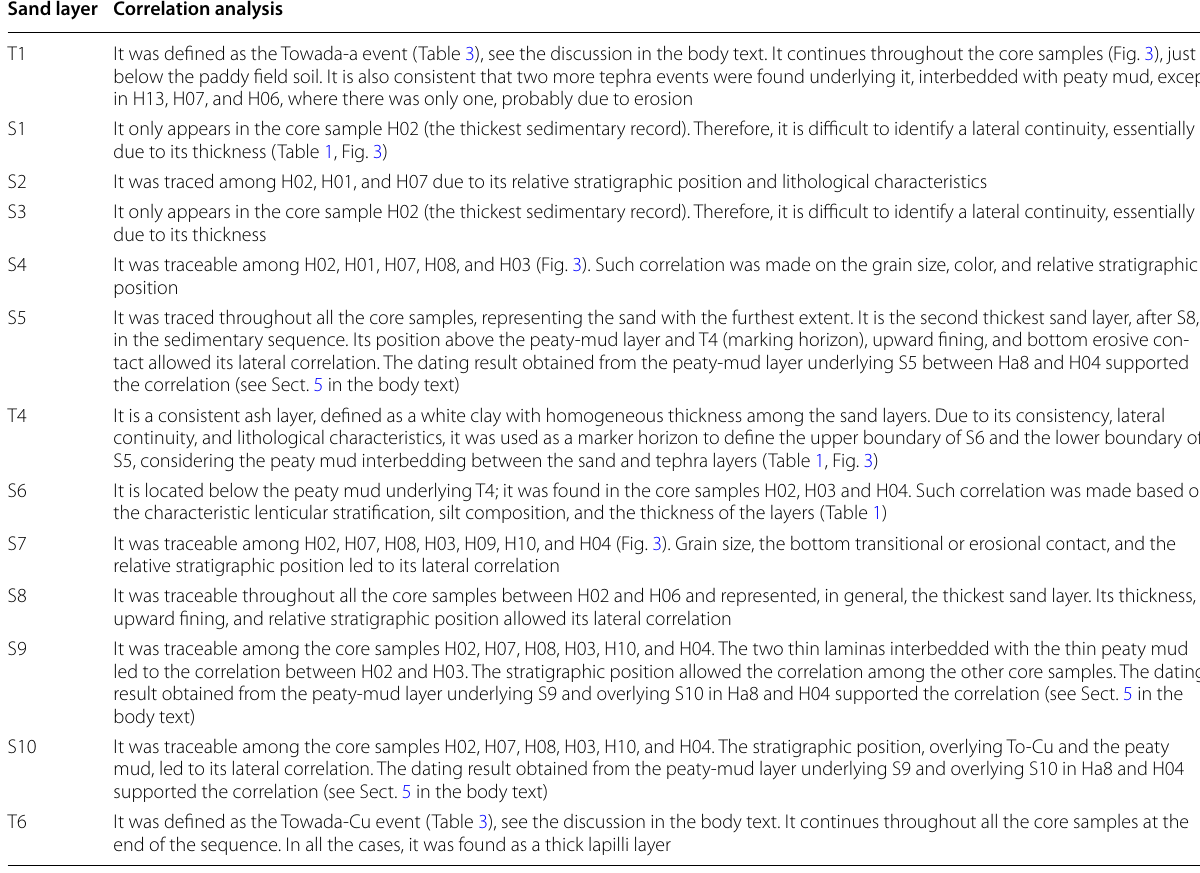
Table 6 Correlation of the sand layers among the core samples Sand layer Correlation